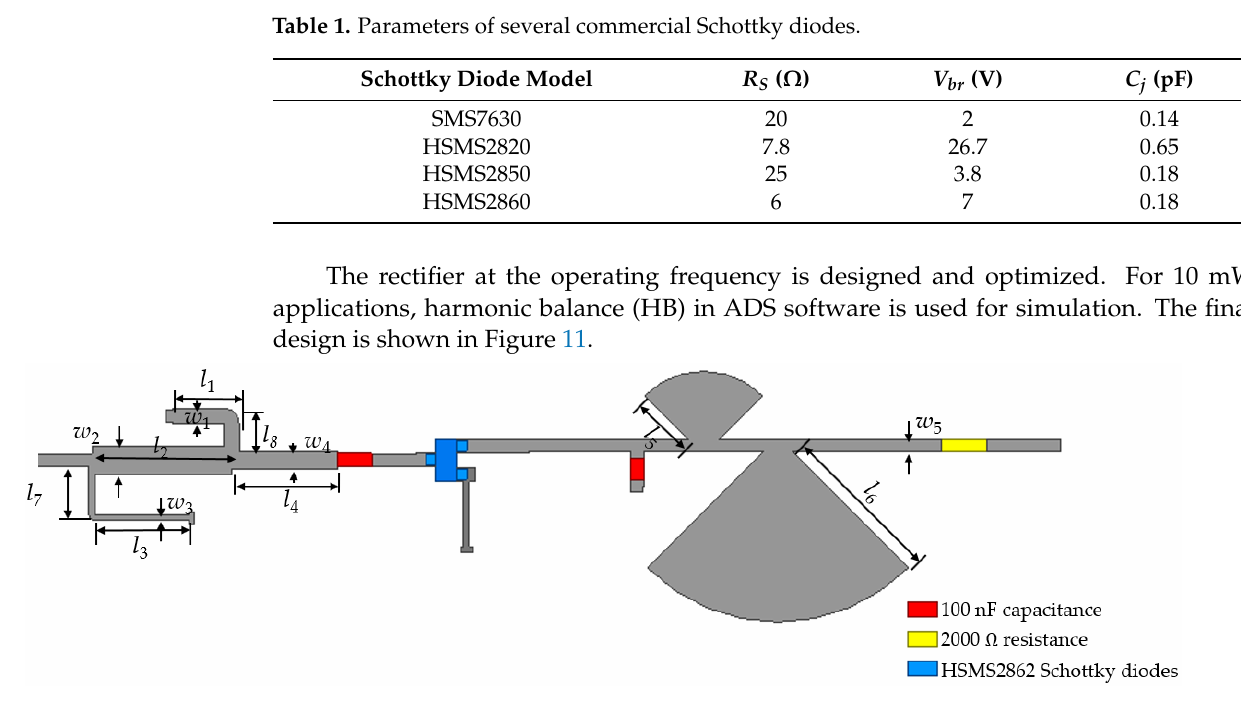
9 = 4.4 mm; w 6 = 0.4 mm; w 7 = 0.9